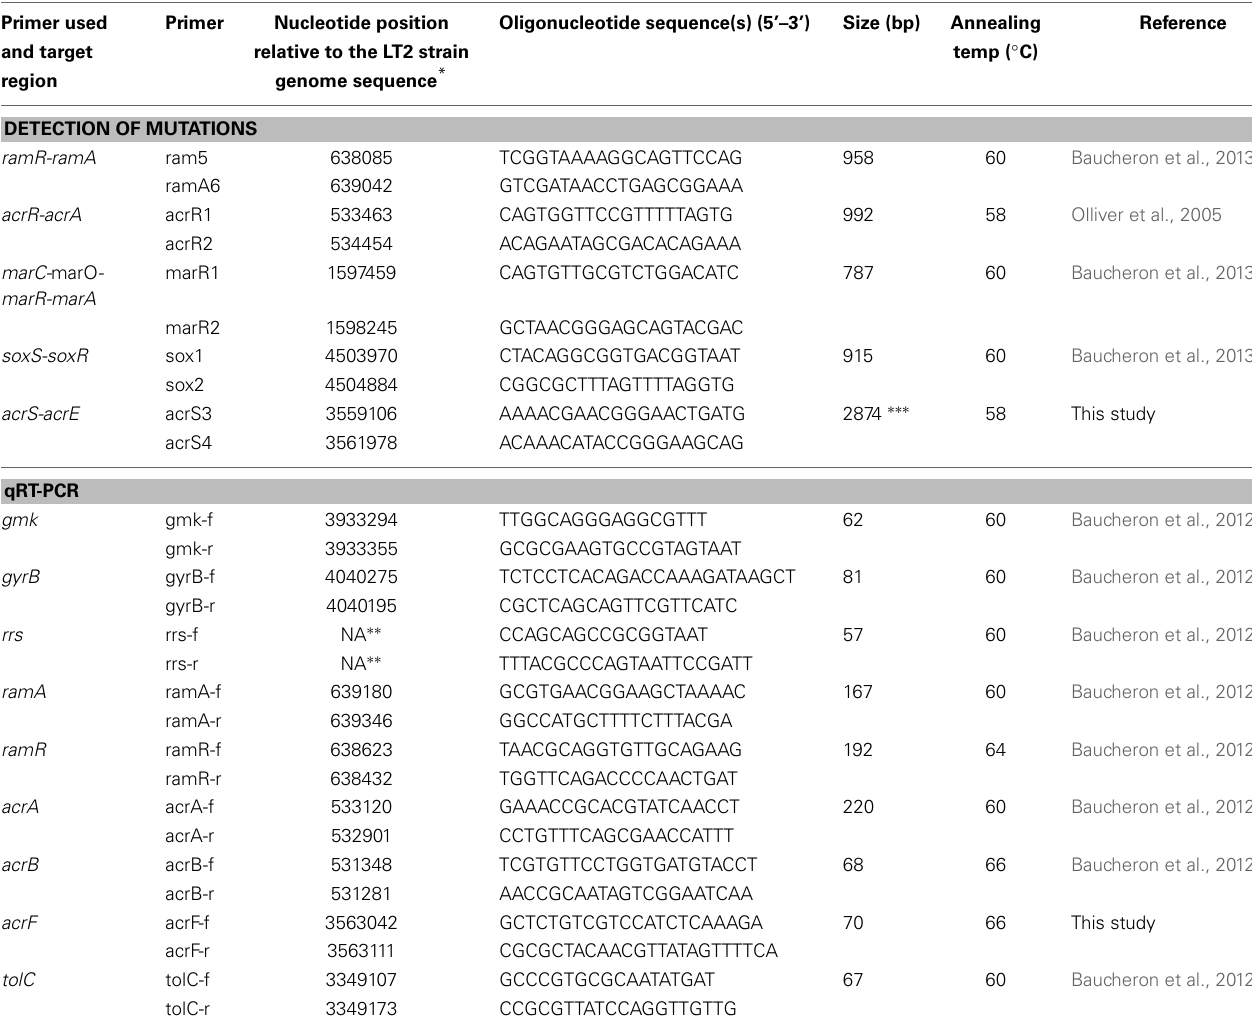
Table 2 | Primers used for PCRs. Primer used